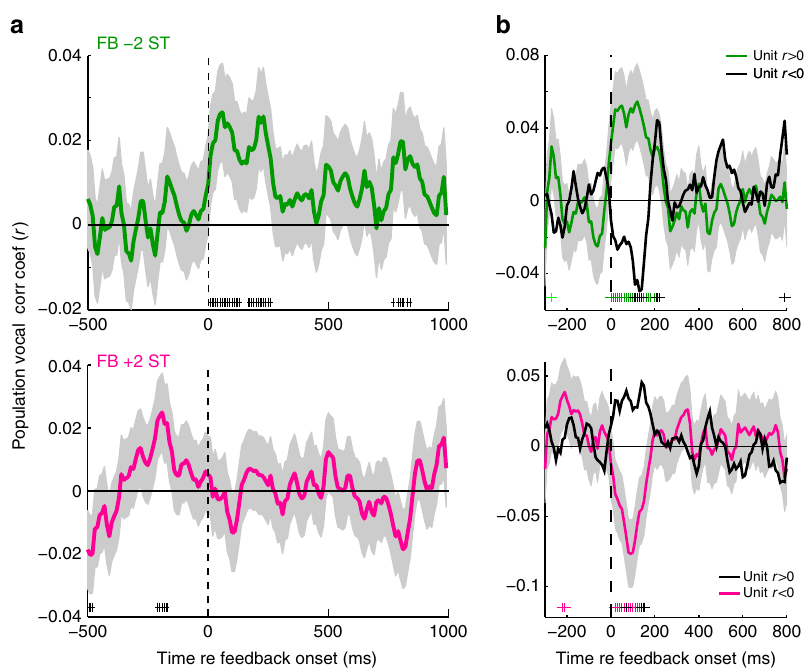
Fig. 5 Population correlations between neural activity and vocal compensation. a Population sliding-window correlation analysis showing timing of correlation coef fi cients between neural fi ring in different time bins and vocal compensation after 200 ms. Results are shown separately for − 2ST and + 2ST (Shaded: 95% CI, + p < 0.05). Correlations develop immediately after the start of altered feedback and persist until the time of vocal compensation onset. b Population correlations dividing unit into r > 0 or r < 0, as in Fig. 4. For clarity, error bars have been omitted from the non-compensatory r -value units (i.e., r -values opposite expected vocal compensation for feedback direction). Signi fi cant correlations are indicated ( + p < 0.05). Sample sizes and statistical details may be found in the Supplementary Note